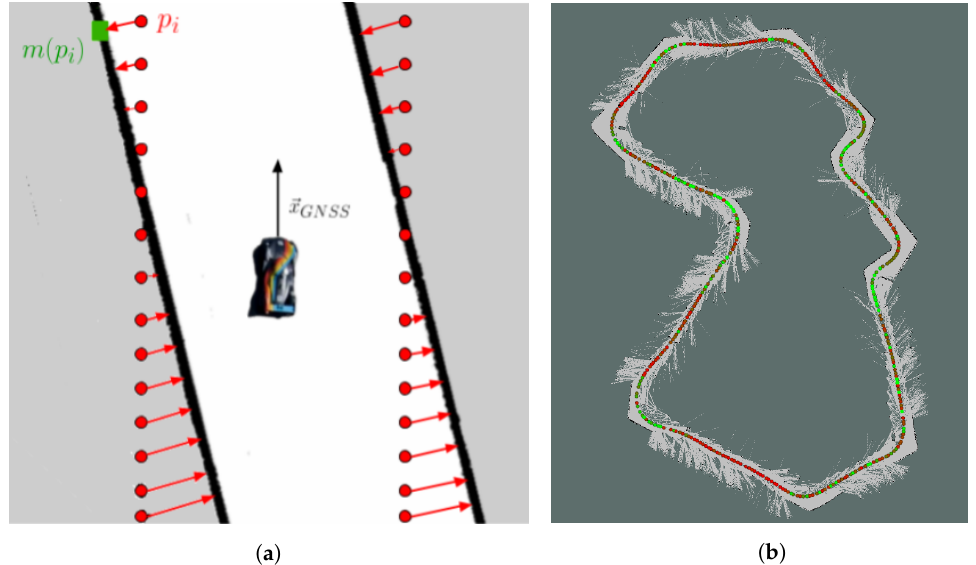
Figure 5. ( a ) Computation of the mapping error e map ( ξ ∗ ( k )) . Given a LiDAR reading place on a GNSS pose, each laser scan point ( p i in red) is compared with its closest map occupied point ( m p ( b ) Result of the map quality assessment procedure on the Zala Zone track map. The circular markers are placed on GNSS positions; the colors, from green to red, represent the values of e map (green markers correspond to lower values of e map